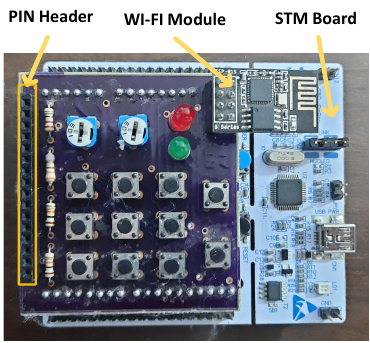
Figure 5. The Proposed CIoT Hardware